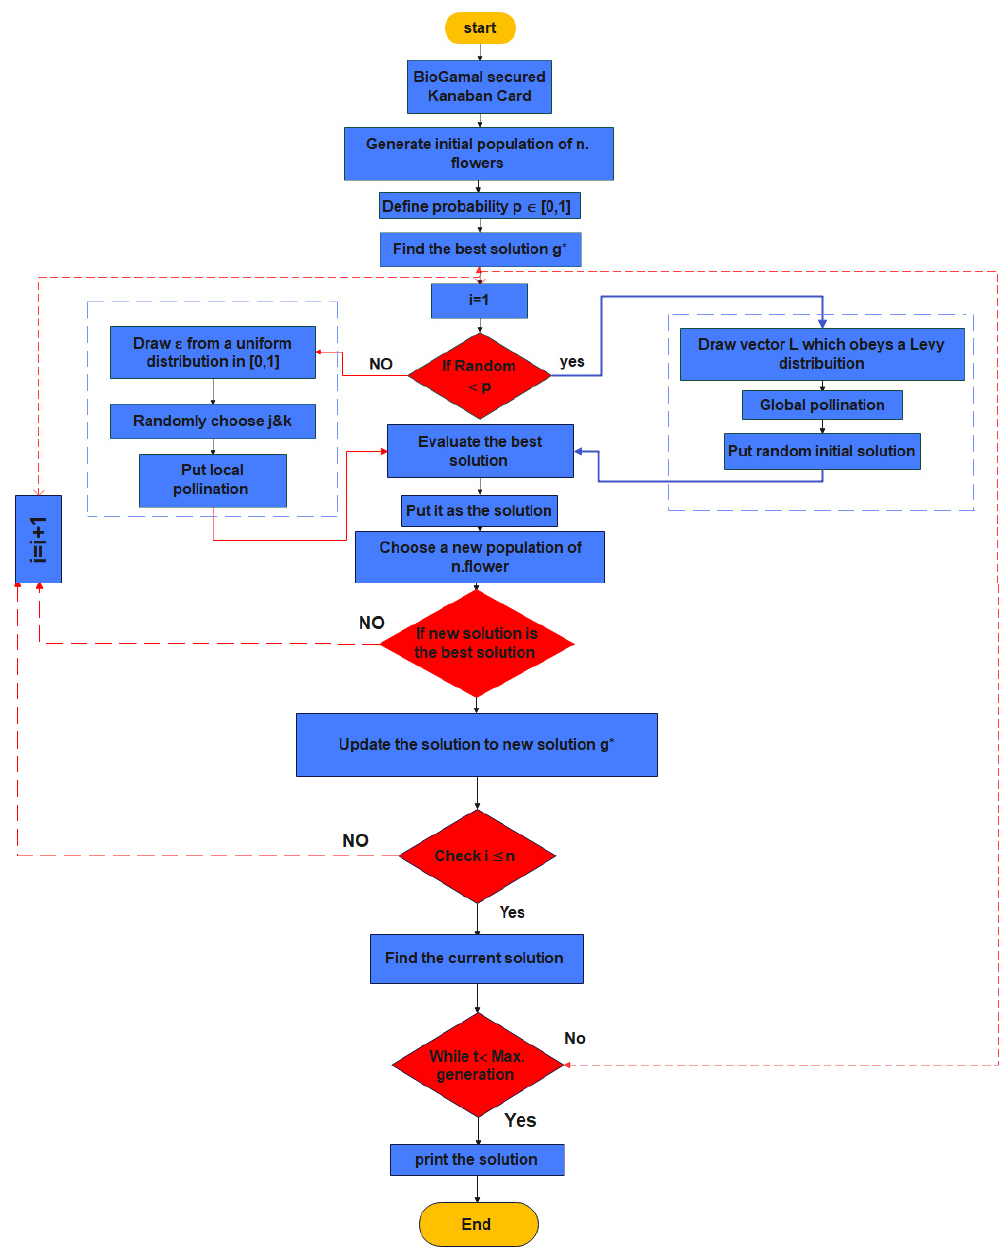
Figure 6. Flow Chart for Flower Pollination Algorithm (FPA) Technique for secured Kanban Card. The first one describes the total production cost, while the total transportation cost is given in the second term. The third and fourth terms show the total transportation cost of the final product and the total cost of the final product,